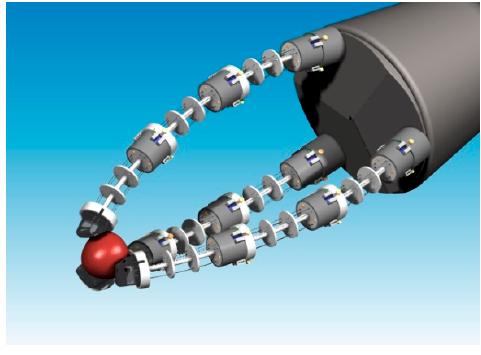
Figure 3. Three-finger gripper.